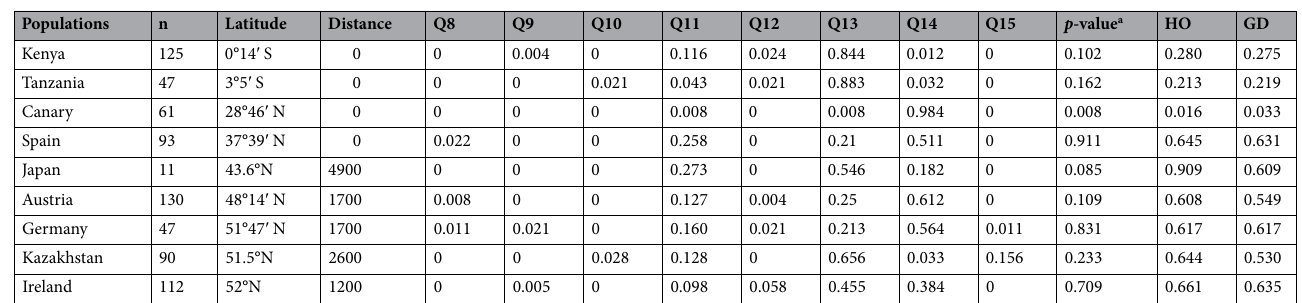
Table 1. Breeding latitude, migration distance [km], Clk poly-Q repeat length frequencies (Q 8–15 ), Hardy– Weinberg exact test p-values, observed heterozygosity (HO) and gene diversity (GD) of nine stonechat ( Saxicola spp .) populations listed by increasing latitude. a Estimated with Markov Chain